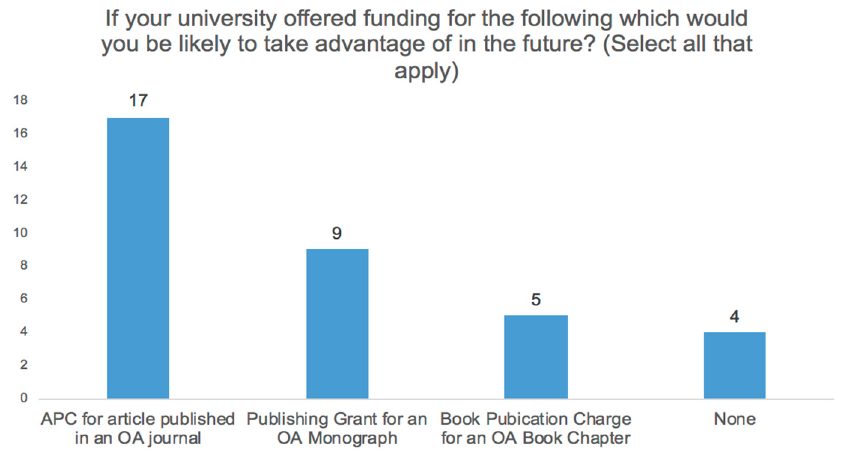
Figure 6. Interest in Other Open Access Funding Opportunities.